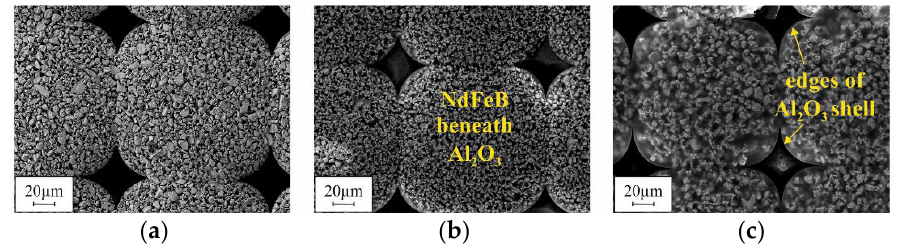
Figure 16. SEM micrographs of the bottom side of micromagnets of design G2 fabricated using ( a ) automated filling with compaction, ( b ) automated filling without compaction and ( c ) manual filling with compaction. The micrographs were obtained with an acceleration voltage of 20 kV. The surrounding silicon has been removed in XeF 2 gas phase as illustrated in Figure 15.